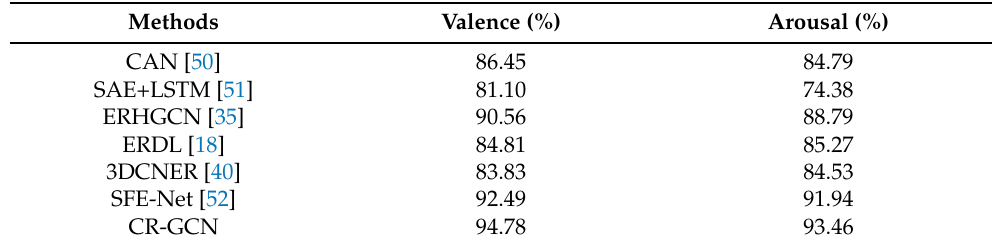
Table 4. Average classification accuracies of other methods in subject-independent experiments.